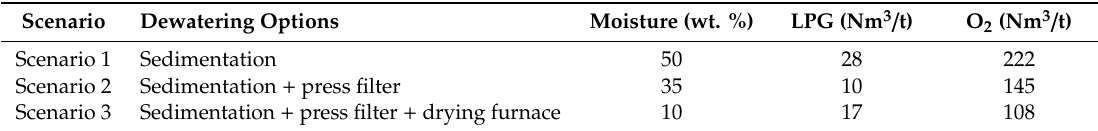
Table 4. Scenarios of BF sludge dewatering options, moisture contents (wt. %) and related OXYFINES consumption of LPG and O 2 (Nm 3 / t).